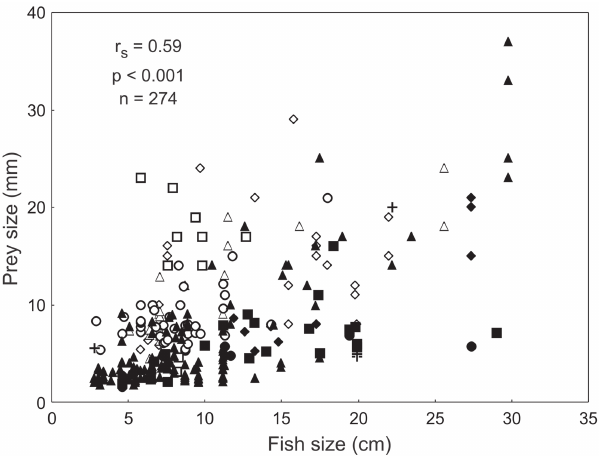
Fig. 7. Scatterplot of prey size vs. fish size for decapods found in the stomachs of three species of snappers. Main food categories identified by different symbols: White diamons = Alpheidae; white triangles = Palaemonidae; White circles = Penaeidae; White squares = Upogebiidae; black diamonds = Grapsidae; black triangles = Portunidae; black circles = Porcellanidae; black squares = Xanthidae; crosses = other items.